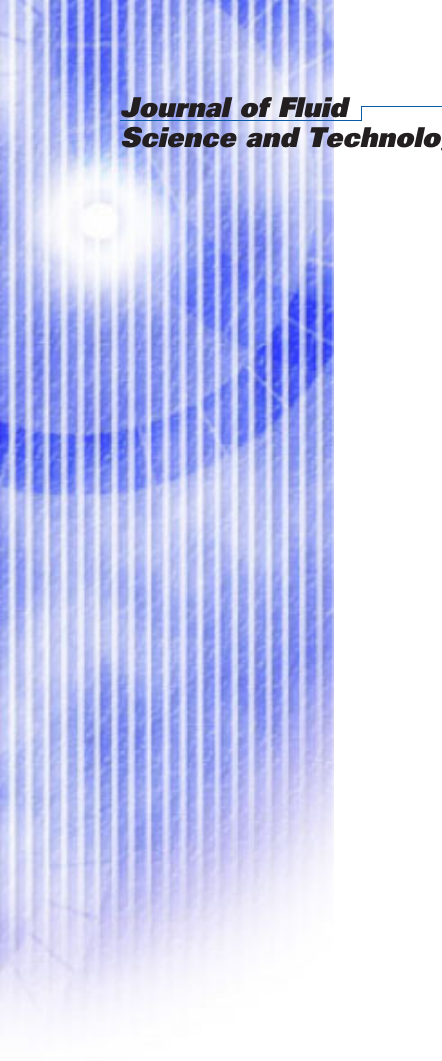
Fig. 4 Mean velocity and velocity fluctuations in subchannel flow at Re T = 580: (a) u + , (b) u (cid:3) + , (c) u (cid:3) + (the wall-normal component is shown for channel), (d) r , RMS 1 , RMS 1 u (cid:3) + (the wall-span component is shown for t , RMS